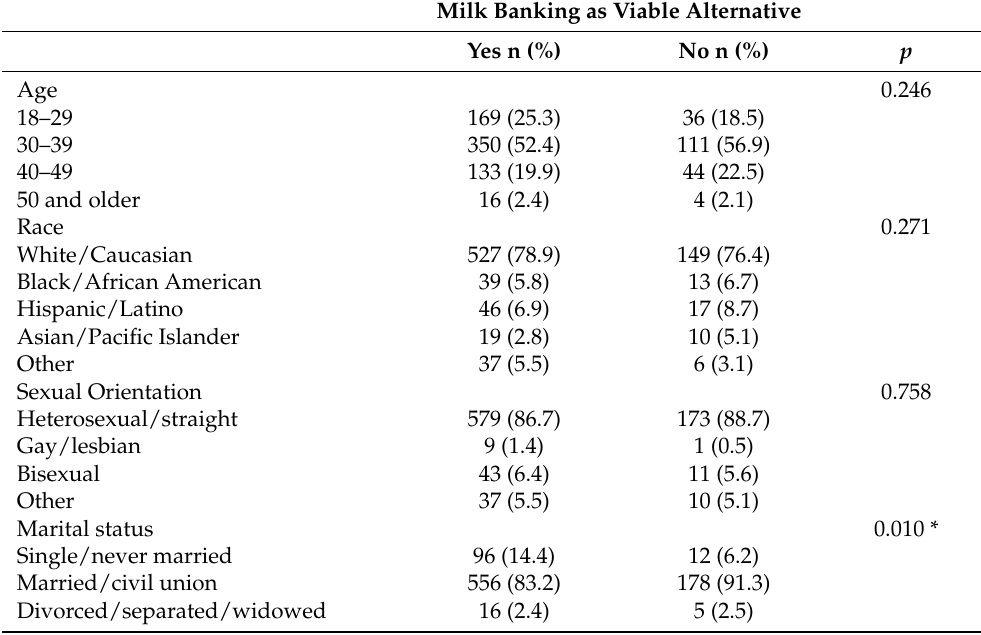
Table 2. Bivariate results of the study sample for milk banking as viable alternative ( N =